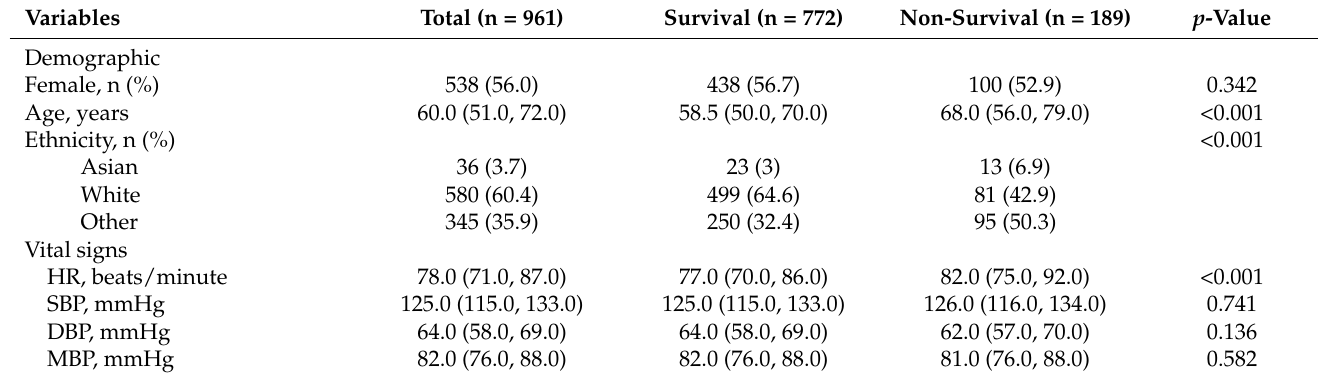
Table 1. The baseline clinical characteristics of patients with non-traumatic subarachnoid